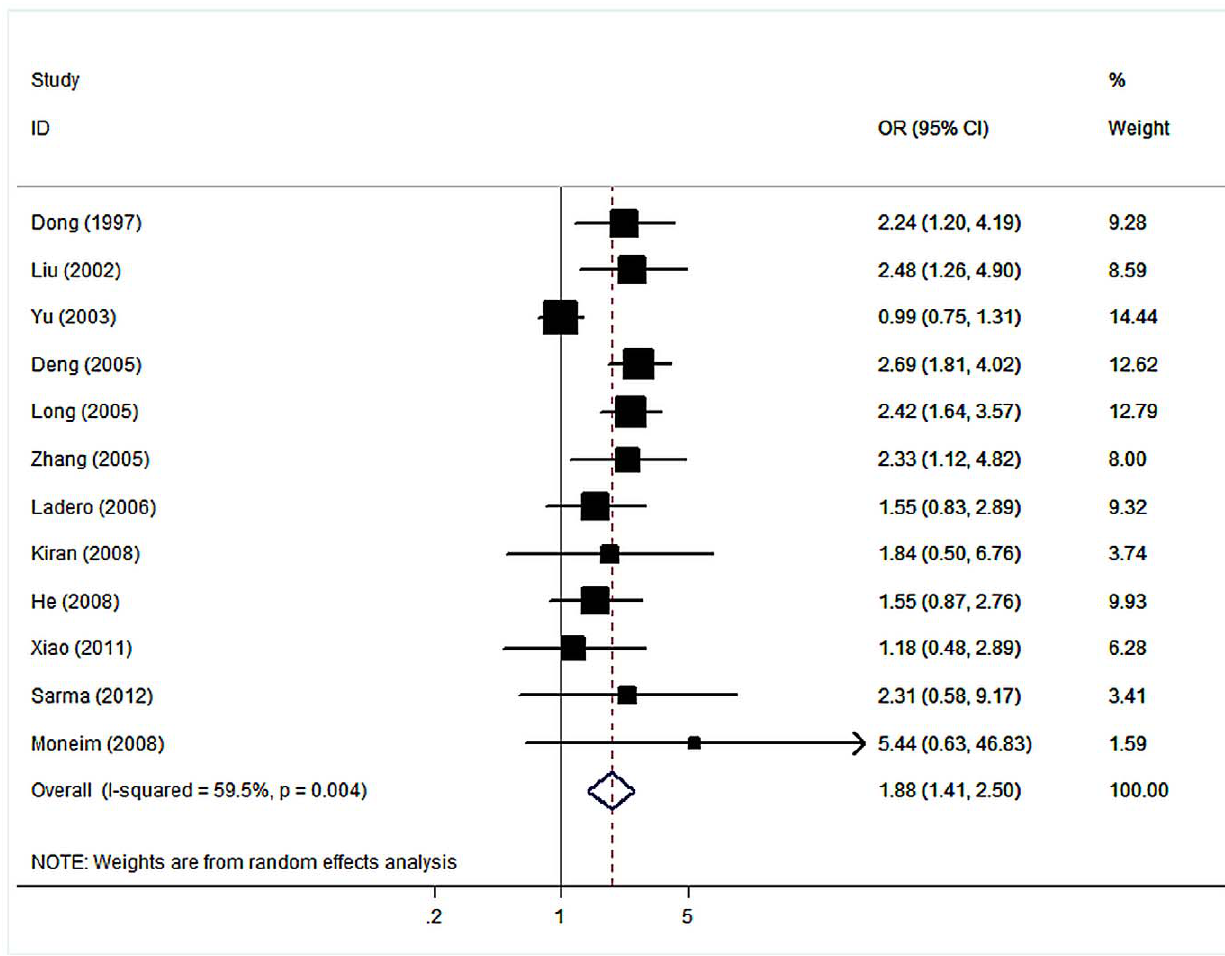
Figure 3. Forest plot for association of dual null genotype of GSTM1/GSTT1 and HCC risk.